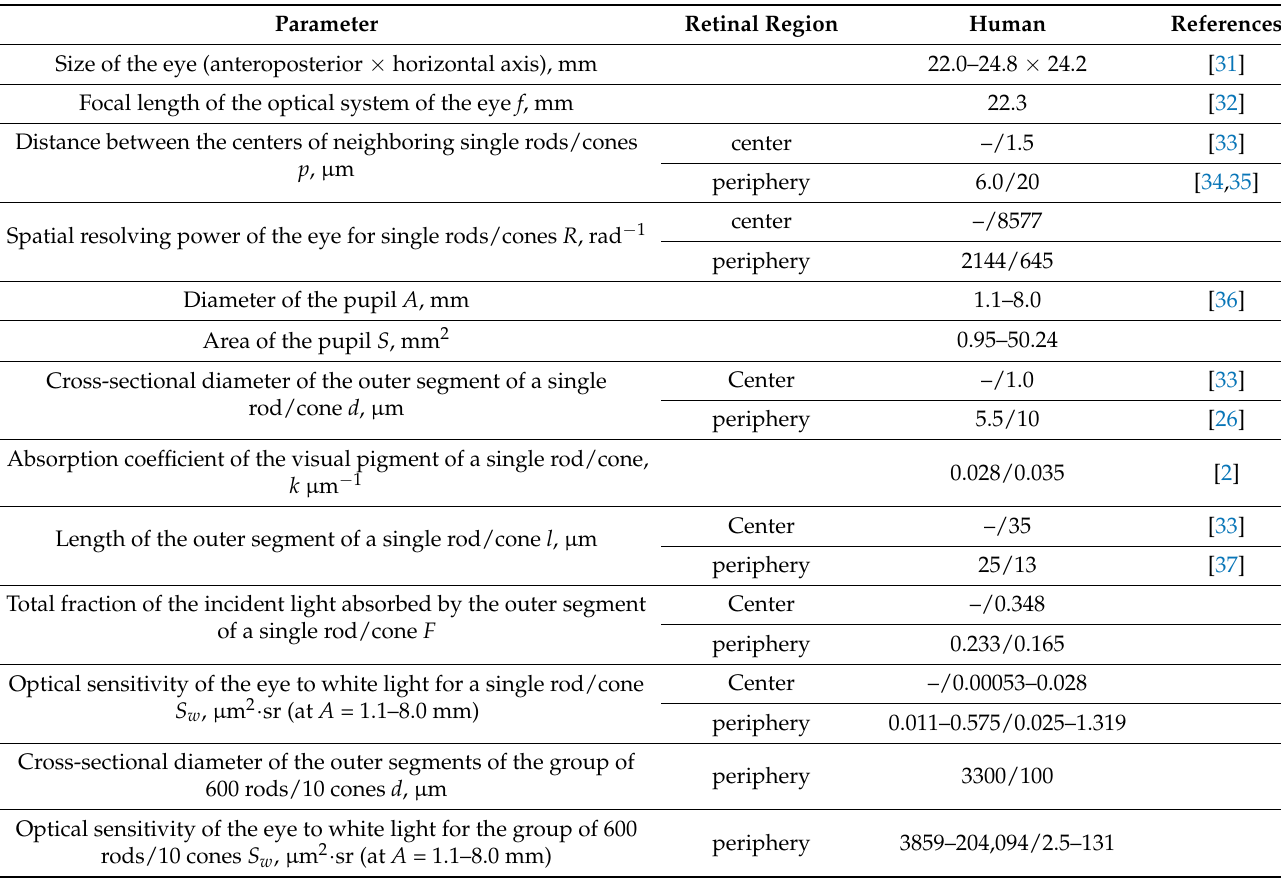
Table 3. Parameters of the human eye.